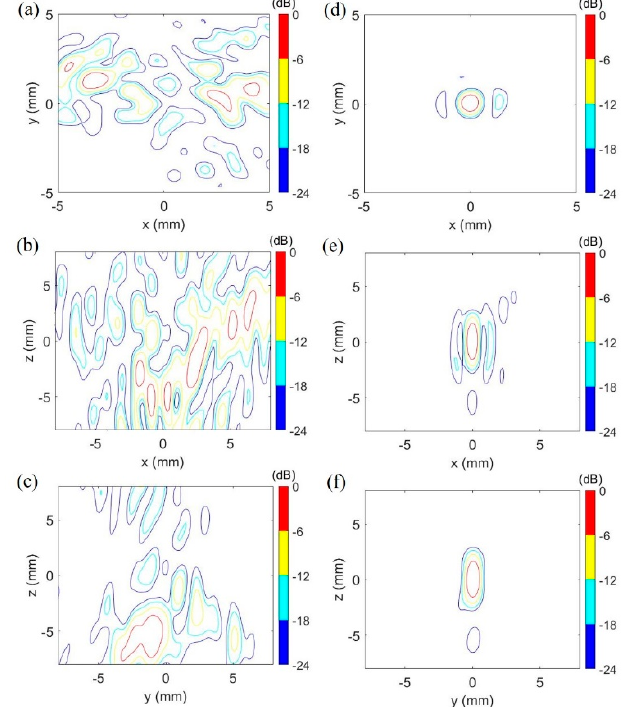
Figure 5. Simulated comparison between natural focusing and phase compensated focusing via the skull. The designated focusing point was the center of the curvature of the 114-element transducer at (0, 0, 0). The focus was distorted by the skull ( a – c ). After compensation of phases, the focal zone was a quasi-ellipsoid ( d – f ). The peak pressure was 8.60 MPa and 1.64 MPa, respectively, for the numerical model without the skull and with skull. dB: 20log (the intensity/peak intensity). Two patterns of trans-skull two-foci focusing were simulated in the brain as shown in Figure 6. The designated focusing points were at (2, 0, 0) and ( − 2, 0, 0) for the focusing pattern 1, and at (0, 2, 0) and (0, − 2, 0) for the focusing pattern 2. A summary of two focus- ing patterns for two transducers is listed in the Table 2. Table 2. Simulated results of two focusing patterns for two transducers.